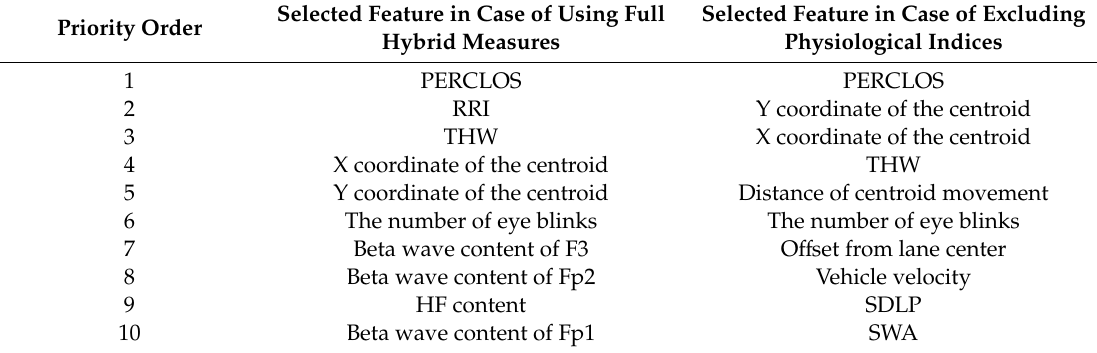
Table 5. Priority of features in the case of using random forest algorithm (Top